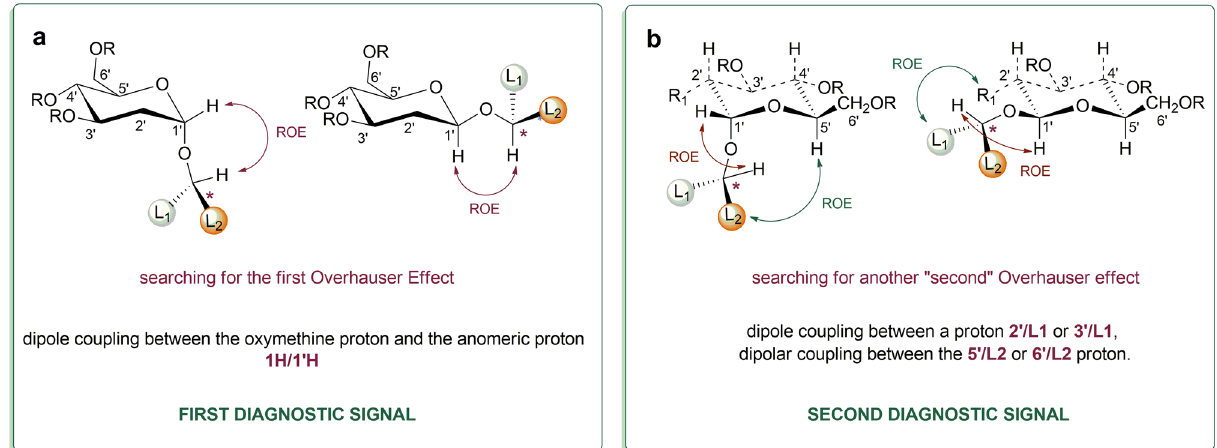
Figure 2. Determination of the absolute configuration of secondary alcohols with the use of dipole couplings: ( a ) first diagnostic signal; ( b ) second diagnostic signal.